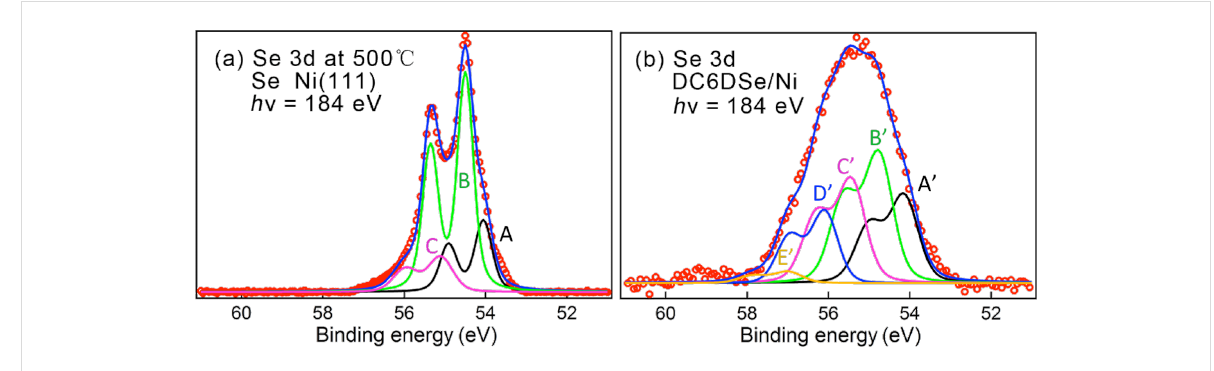
Figure 5: XPS in the Se 3d region after (a) initial selenization of Ni with atomic selenium and heating to 500 °C and (b) after adsorption of DC6DSe on Ni. See Supporting Information File 1, Tables S1 and S2 for peak positions.